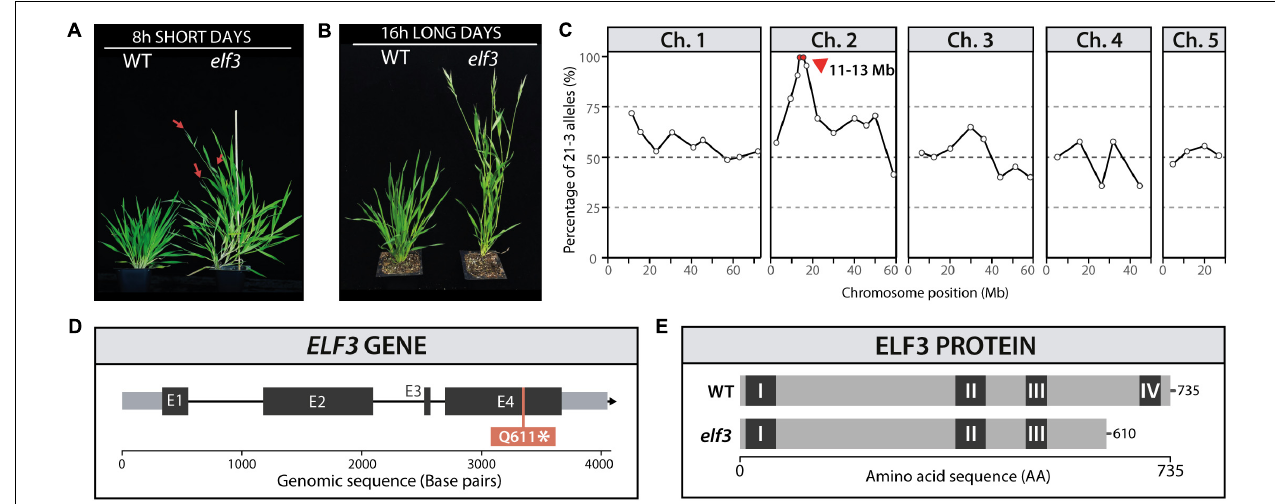
FIGURE 1 | Identification of the elf3 mutant. Phenotype of the elf3 mutant and wild-type (WT) Brachypodium distachyon plants under (A) 8 h (80 days) and (B) 16 h photoperiods (50 days). The red arrows indicate early emerging spikes. (C) InDel mapping of the segregation of the early flowering phenotype in an M2 mapping population (Bd21-3 and Bd3-1). (D,E) Schematic representation of the ELF3 gene ( D ; E1 to E4 indicate exons) and the ELF3 protein ( E ; regions I to IV indicate conserved protein